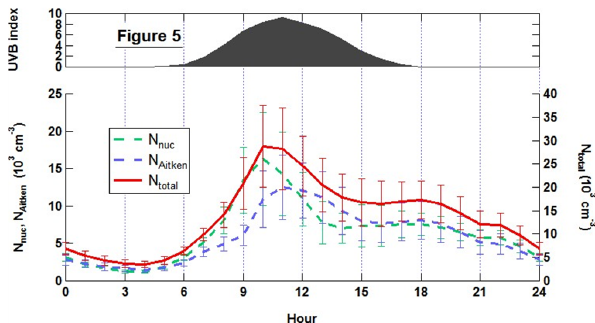
Fig. 5. Diurnal variation of particle number concentrations of total ( N total , red solid line), Aitken ( N Aitken , blue dash line), and nucle- ation ( N nuc , green dash line) modes in lower panel, also UVB index in upper panel. The error bars show the values of 95% confidence